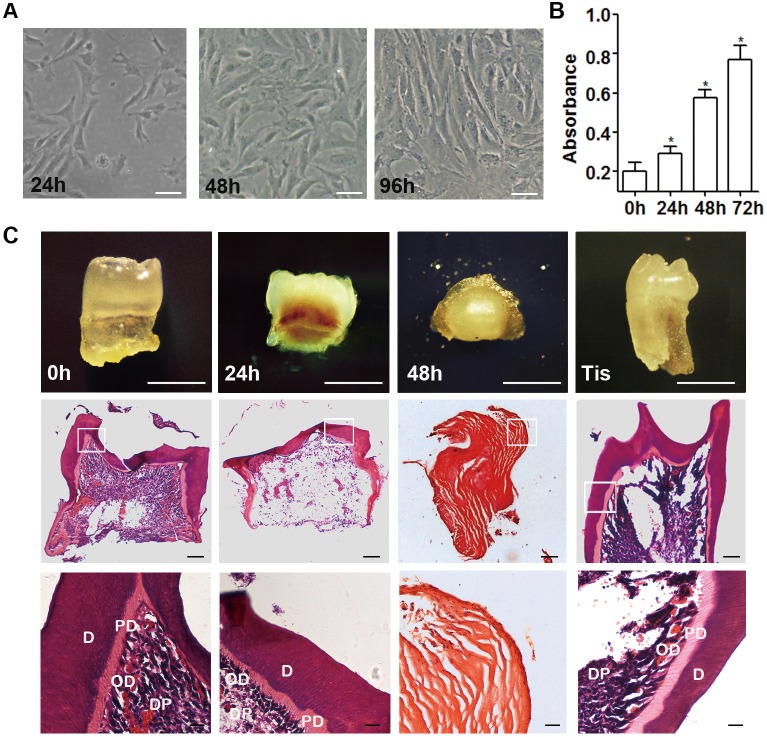
Impaired odontogenic potential in cultured mDMCs.(A) mDMCs possess a fibroblast-like or elliptic morphology. Cell density increased significantly and the morphological alteration was visible from 24 h to 96 h. (B) Cells continued to proliferate in culture and cell quantity doubled in 48 h. (C) Recombinants with freshly isolated mDMCs and cells cultured for 24 h formed tooth after subrenal culture, but recombinants with cells cultured for 48 h formed cysts. Recombinants with E14.5 dental mesenchyme (Tis) were used as positive control. H&E staining showed the presence of tooth structure or eosinophilic amorphous matrix. D, dentin; PD, predentin; DP, dental pulp; OD, odontoblast. Scale bar: A, B = 50 μm; C = 500 μm.